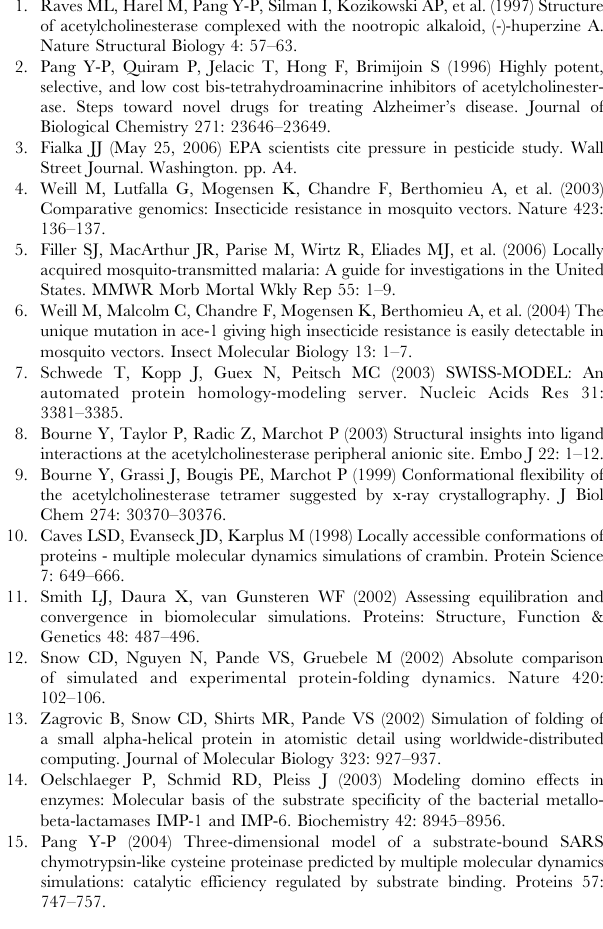
Figure S3 Definitions of atom names of acetylcholine Found at: doi:10.1371/journal.pone.0000058.s004 (1.11 MB